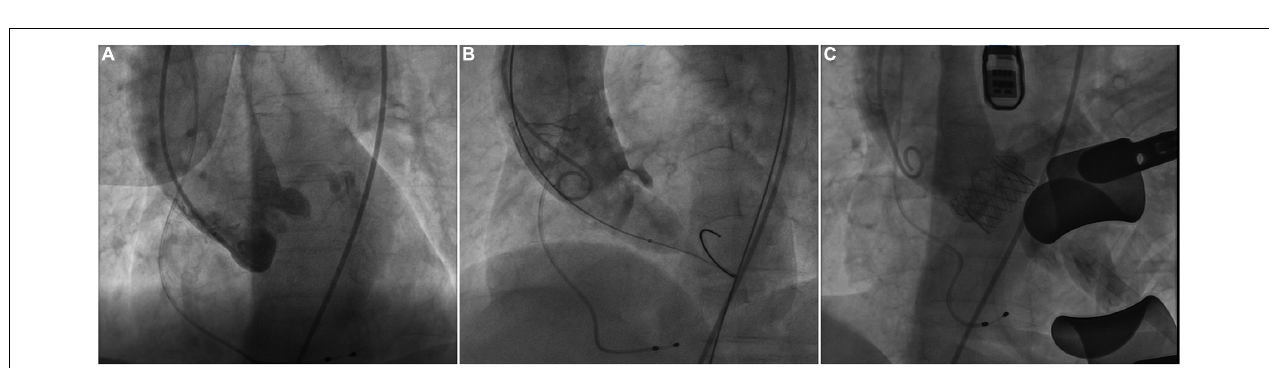
FIGURE 1 | Pre-procedural computed tomography assessment of aortic root. (A) Annular perimeter: 73.1 mm and annular area: 414.1 mm 2 . (B) Left-, right- and non-sinuses of Valsalva dimensions: 31.6 mm * 30.7 mm * 30.7 mm. (C) Average sinotubular junction diameter: 27.6 mm. (D,E) The height of coronary arteries: 11 mm (left) and 14.1 mm (right). (F) The distance from the edge of the calcified nodule to right coronary ostium: 23 mm.